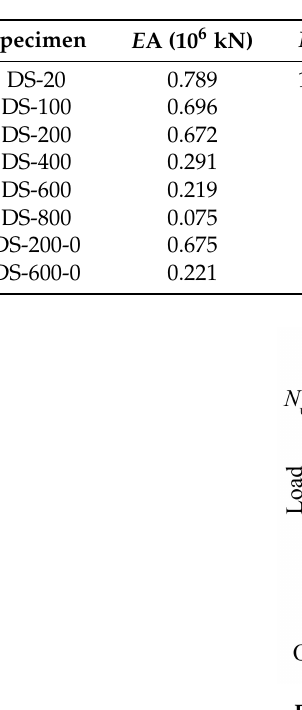
Table 5. Testing results.